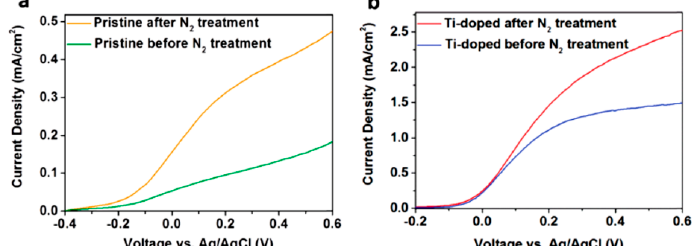
Figure 9. The photocurrents of ( a ) pristine and ( b ) Ti-doped hematite before and after N 2 treatment under AM 1.5 G solar simulator illumination. The N 2 treatment is carried out in nitrogen gas at 600 °C for 2 h. Reprinted with permission from ref. [31]. Copyright 2017. The Royal Society of Chemistry.